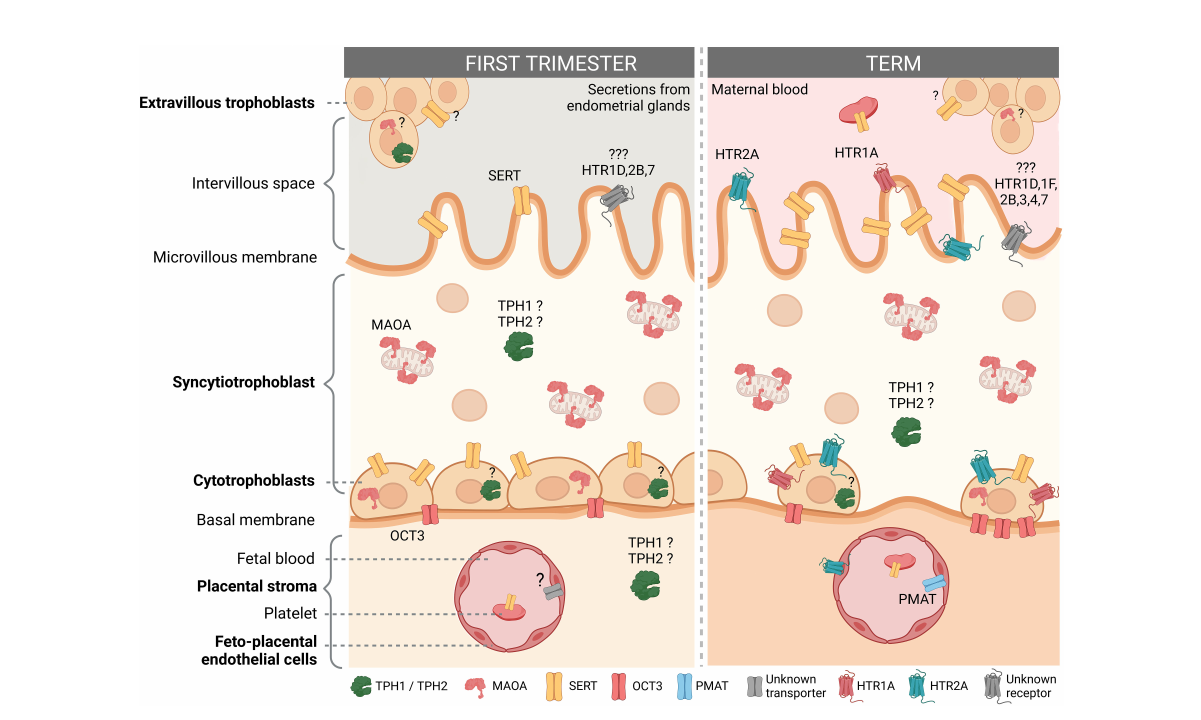
FIGURE 2 Localization of the serotonin system components in the human placenta according to gestational age. The fi gure shows the presence and localization of the components of the serotonin system in the human fi rst trimester and term placenta according to the available literature. For details see main text. Components for which the results of different studies do not agree or which are reported only at the mRNA level are indicated with a question mark (?). Cell types not studied to date, such as mast cells, Hofbauer cells and other stromal cells are not shown. Created with BioRender.com.